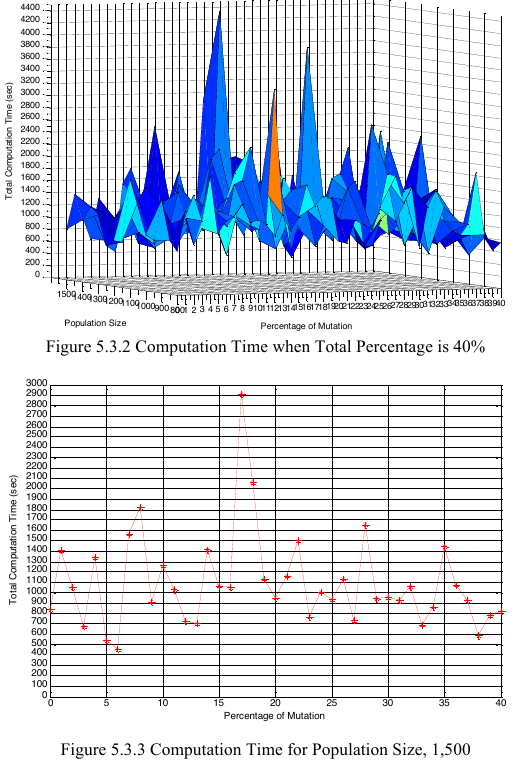
Figure 5.2.2 Computation Time when Total Percentage is 30%